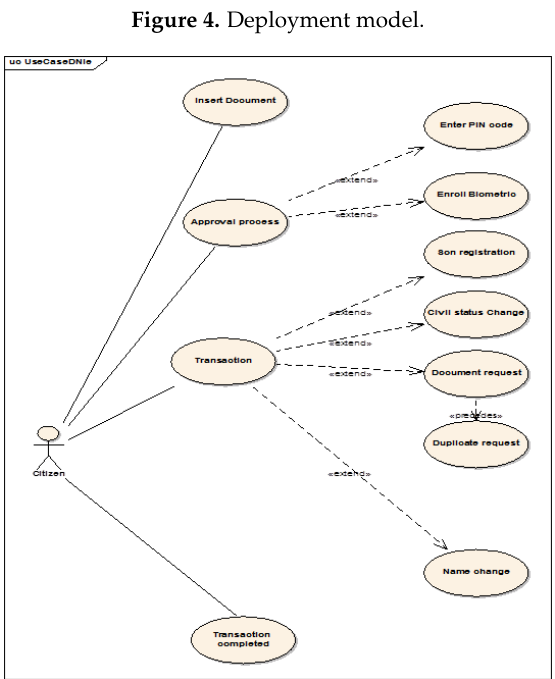
Figure 5. Use case